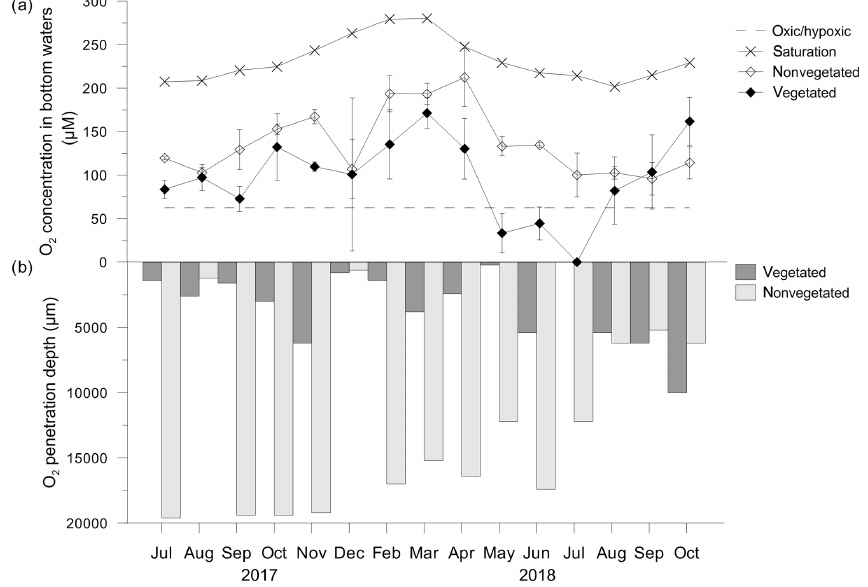
Figure 6. (a) Oxygen (O 2 ) concentrations in bottom waters in, and (b) O 2 penetration depths above, vegetated and nonvegetated sediment. O 2 at the saturation level was calculated according to the temperature and salinity measured in seawater on the sampling dates; O 2 at the hypoxic frontier ( ∼ 62 . 5µM) was taken from Vaquer-Sanyer and Duarte (2008).